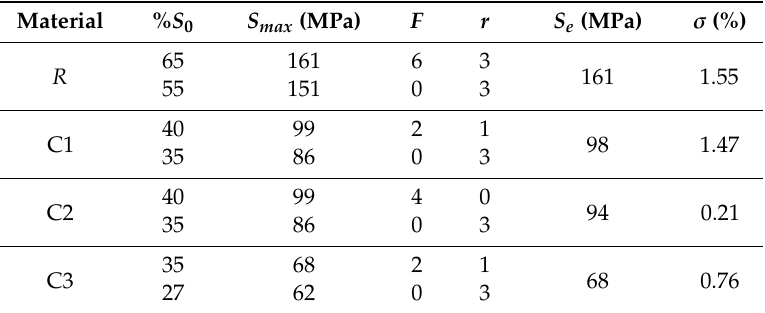
Table 5. Fatigue limit ( S e ), and the percentage deviation ( σ %) calculated considering a technological life level of 2 × 10 6 cycles.